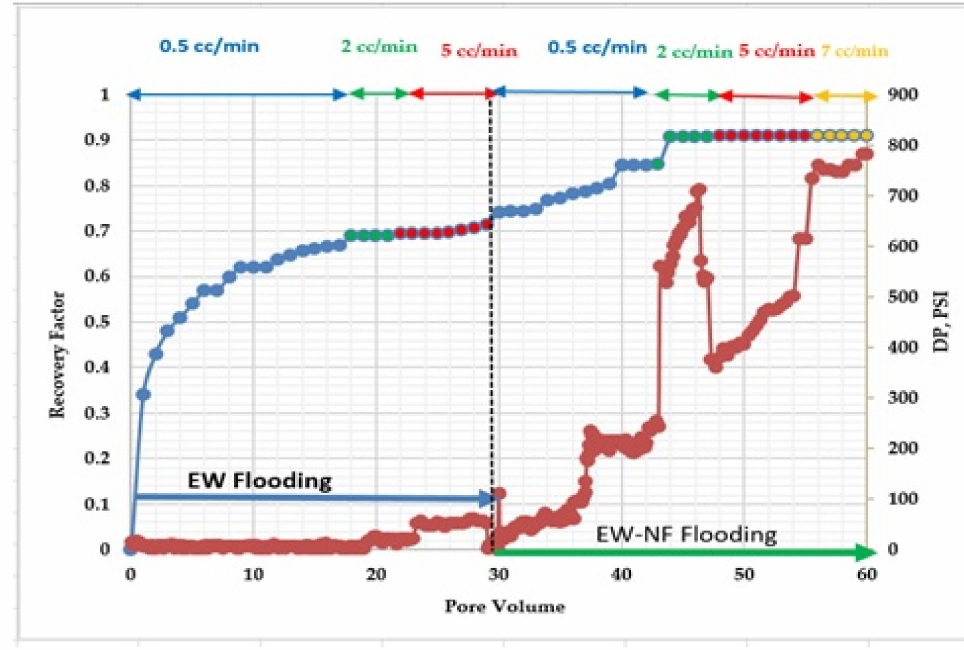
Figure 20. Results for oil recovery from EW and EW/NF hybrid flooding.